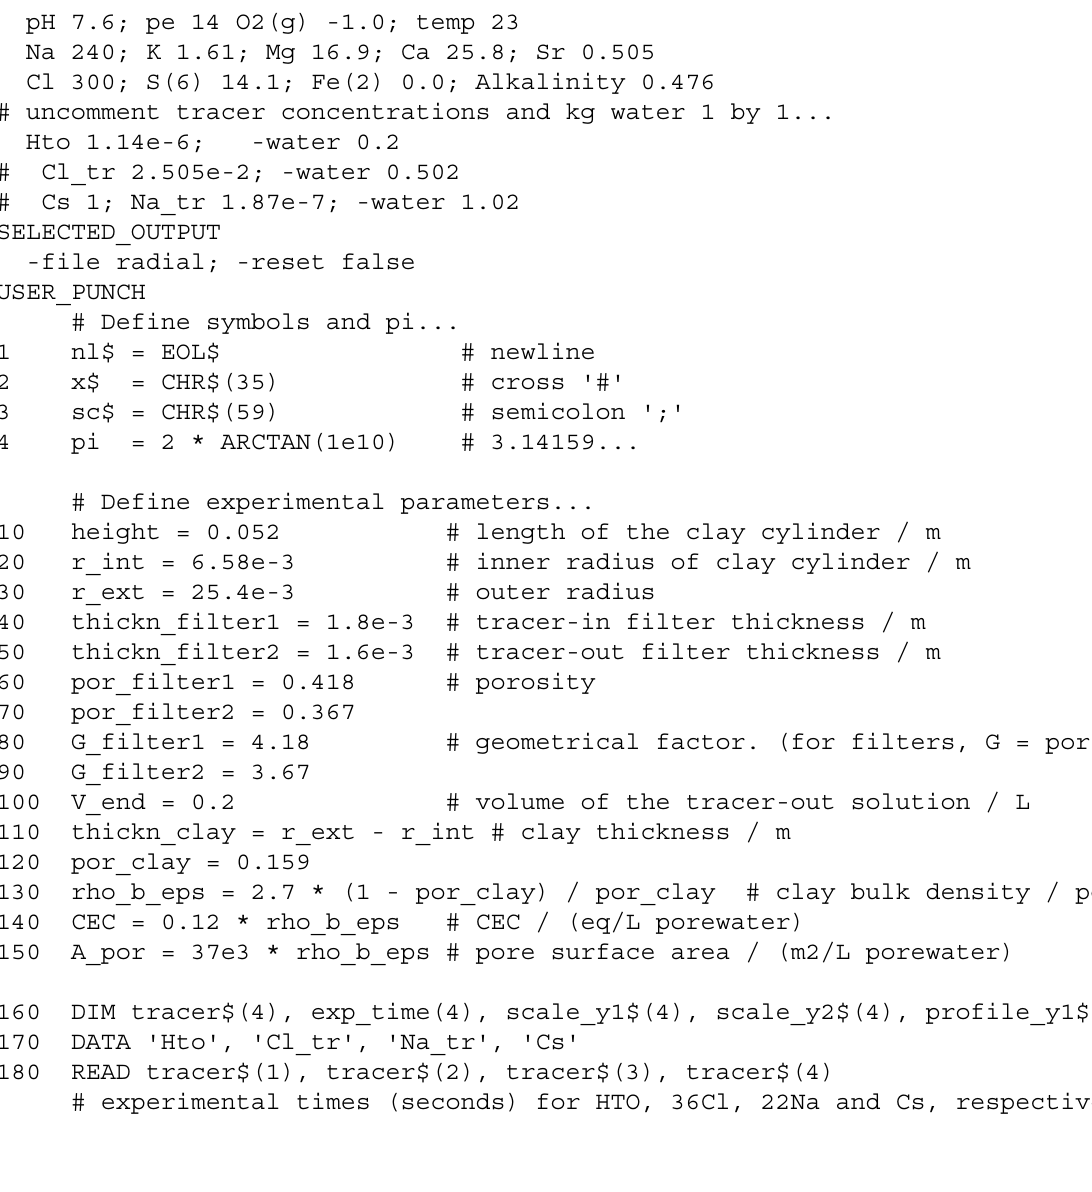
Table 60. Input file for example 21.—Continued KNOBS; -diagonal_scale true # -tolerance 1e-20 # because of low concentrations SOLUTION 3 tracer